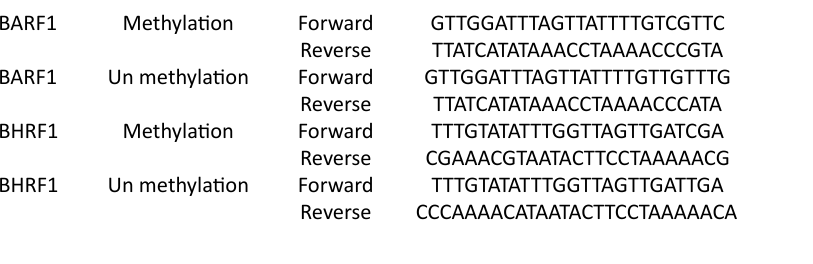
Table 2. Sequences of the primer sets for the methylation specific polymerase chain reaction (MSP) used in this study